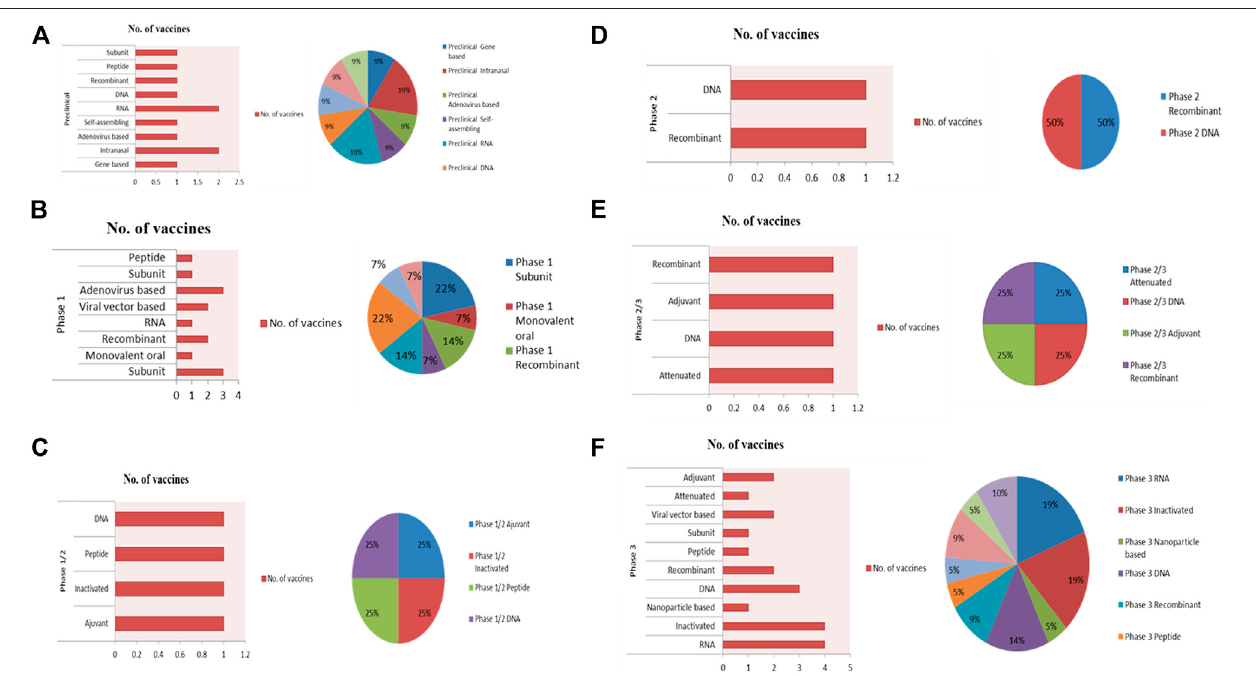
FIGURE4| LandscapeofCOVID-19vaccine development.AsofDecember 4, 2020,165vaccine candidatesare undergoing developmentbyacademic labsand industry. (A) , 86 vaccine candidates have entered pre-clinical trials. (B) , 41 vaccine candidates have entered Phase 1 trials. (C) , four vaccine candidates have entered Phase 1/2 trials. (D) , 17 vaccine candidates have entered Phase 2 trials. (E) , four vaccine candidates have entered Phase 2/3 trials. (F) , 13 vaccine candidates have enteredPhase3trials.Thevaccinecandidatedatawascompiledfromsearchingvaccinetrackerresources:RegulatoryAffairsProfessionalsSociety(https://www.